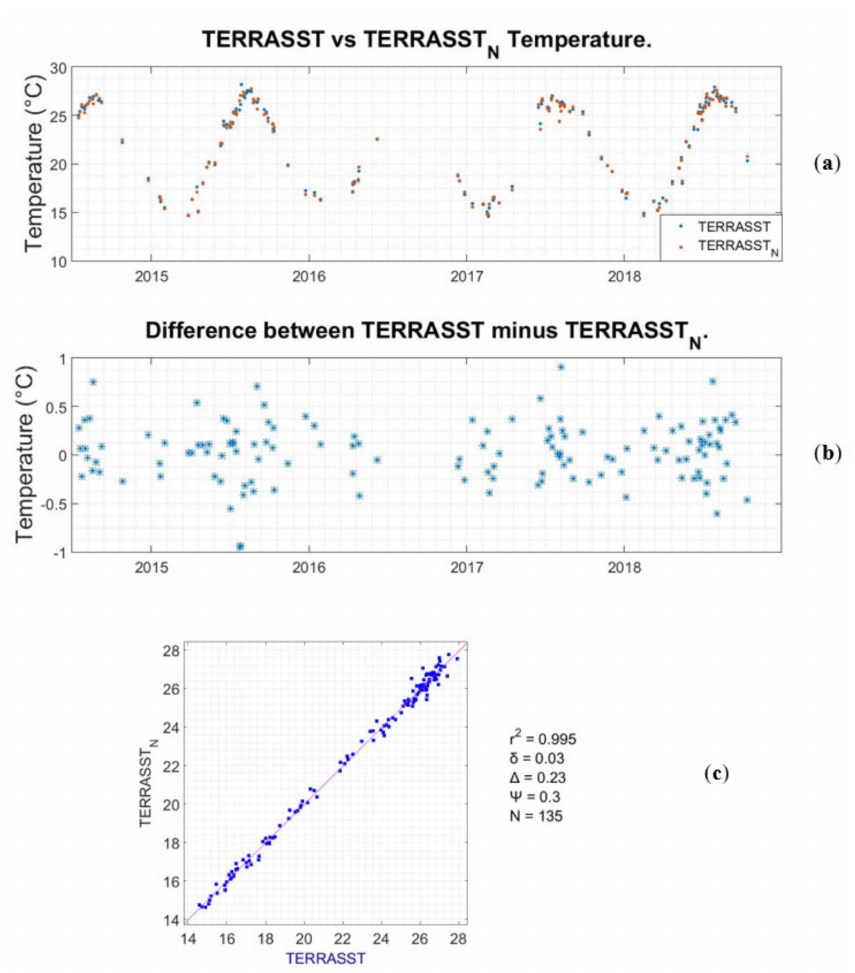
Figure 10. ( a ) TERRASST (in situ logger’s cell) data compared with TERRASST_N (respective northern adjacent cell) data from the same satellite’s swath. All data have quality flags of 0, 1, and 2. ( b ) Di ff erence between the TERRASST minus the TERRASST_N dataset. ( c ) Correlation plot between the TERRASST and the TERRASST_N dataset (refer to Section 2.4 for definitions).